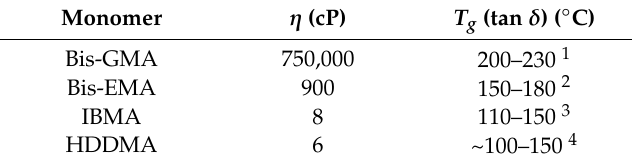
Table 1. Room temperature viscosities of monomers and the T g s of their respective polymers.